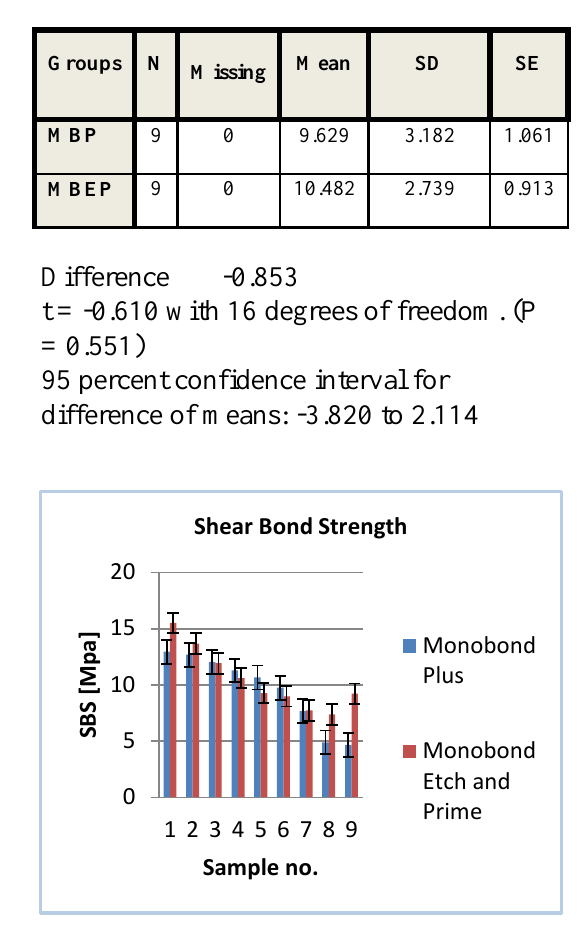
Figure 3: Mean shear bond strength values of the tested groups showing the shear bond strengths with standards error between the